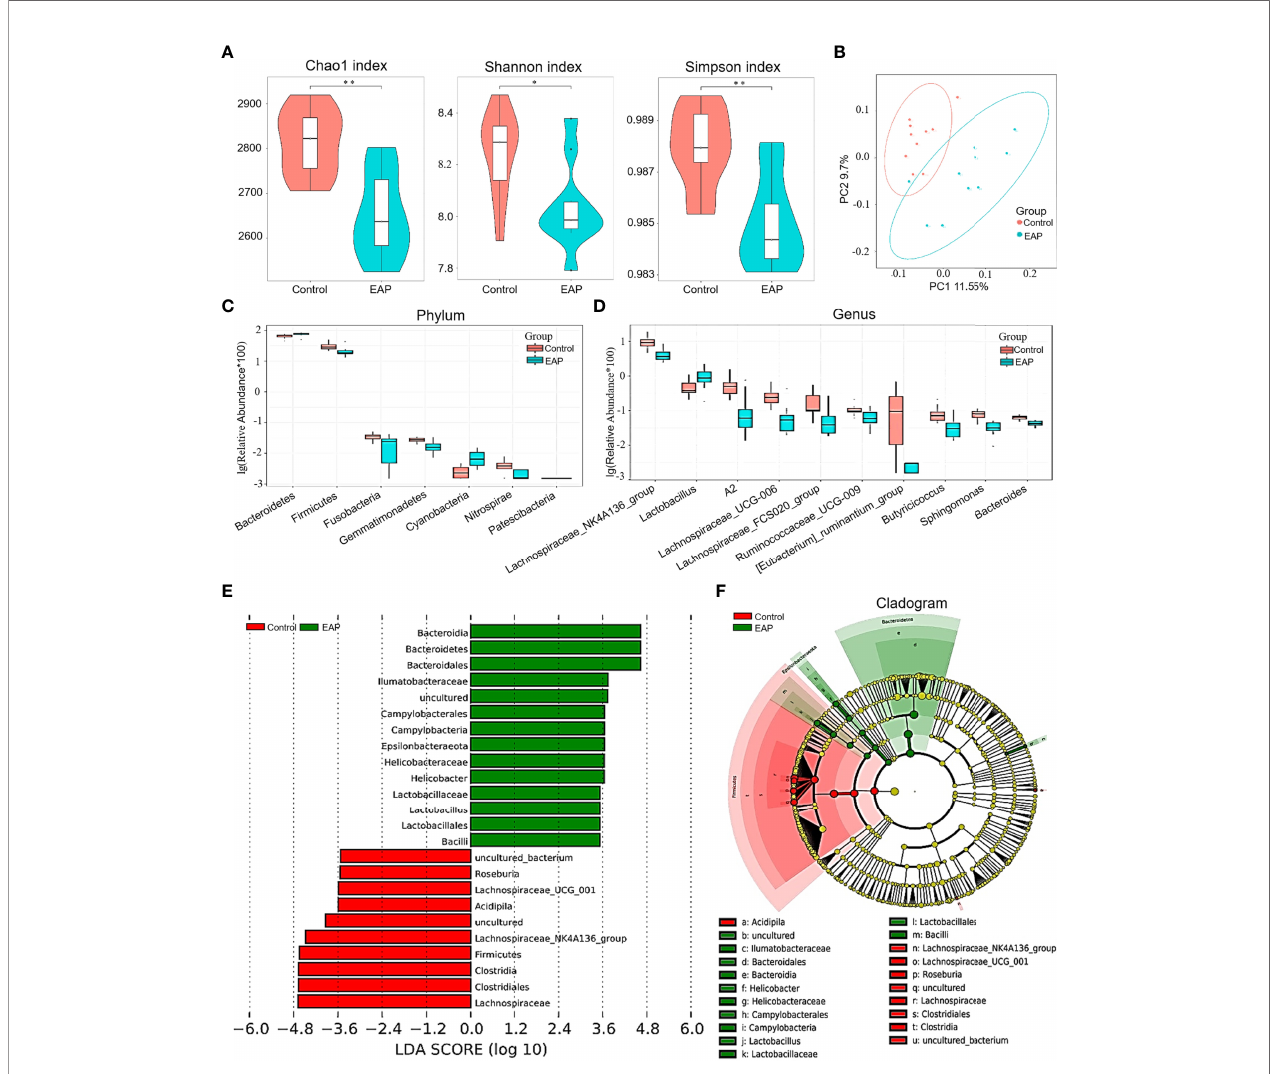
FIGURE 3 | Comparison of gut microbiome between control and EAP mice. (A) a -diversity indices (Chao 1 index, Shannon index, and Simpson index) of bacterial 16S rRNA gene of fecal samples from control and EAP mice. (B) b -diversity (Bray – Curtis similarity index) of bacterial 16S rRNA genes of fecal samples from control and EAP mice. Most of the dots in the EAP group were separated from those in the control group. (C) Relative abundance of gut micro fl ora at the genus level from control and EAP mice. (D) Relative abundance of gut micro fl ora at the genus level from control and EAP mice. (E) A LEfSe analysis of differentially abundant genera from control and EAP mice. (F) A cladogram of the differentially abundant bacteria from control and EAP mice. n = 10/group; * p < 0.05; ** p < 0.01; EAP, experimental autoimmune